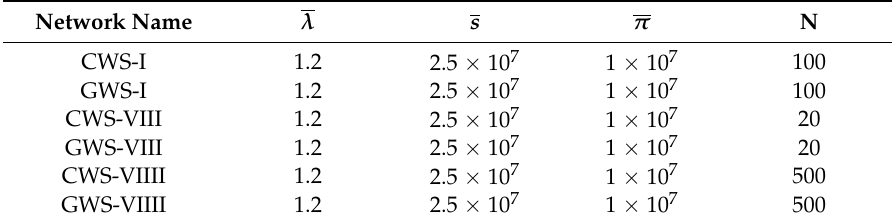
Table 7. Parameters of Simulation VI.